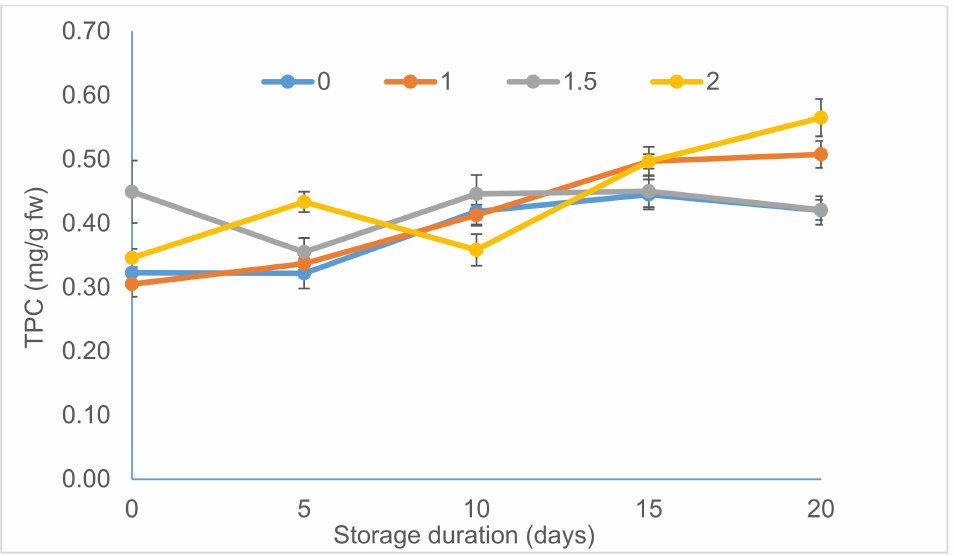
Figure 7. The interaction effects of CaCl 2 (0, 1%, 1.5%, and 2%) and storage durations (0, 5, 10, 15, and 20 days) on the amount of TPC of tomato fruit stored at ambient temperature (28 ± 2 ◦ C and 75 ± 5% RH). Vertical bars indicate the standard error of means for 4 replicates.